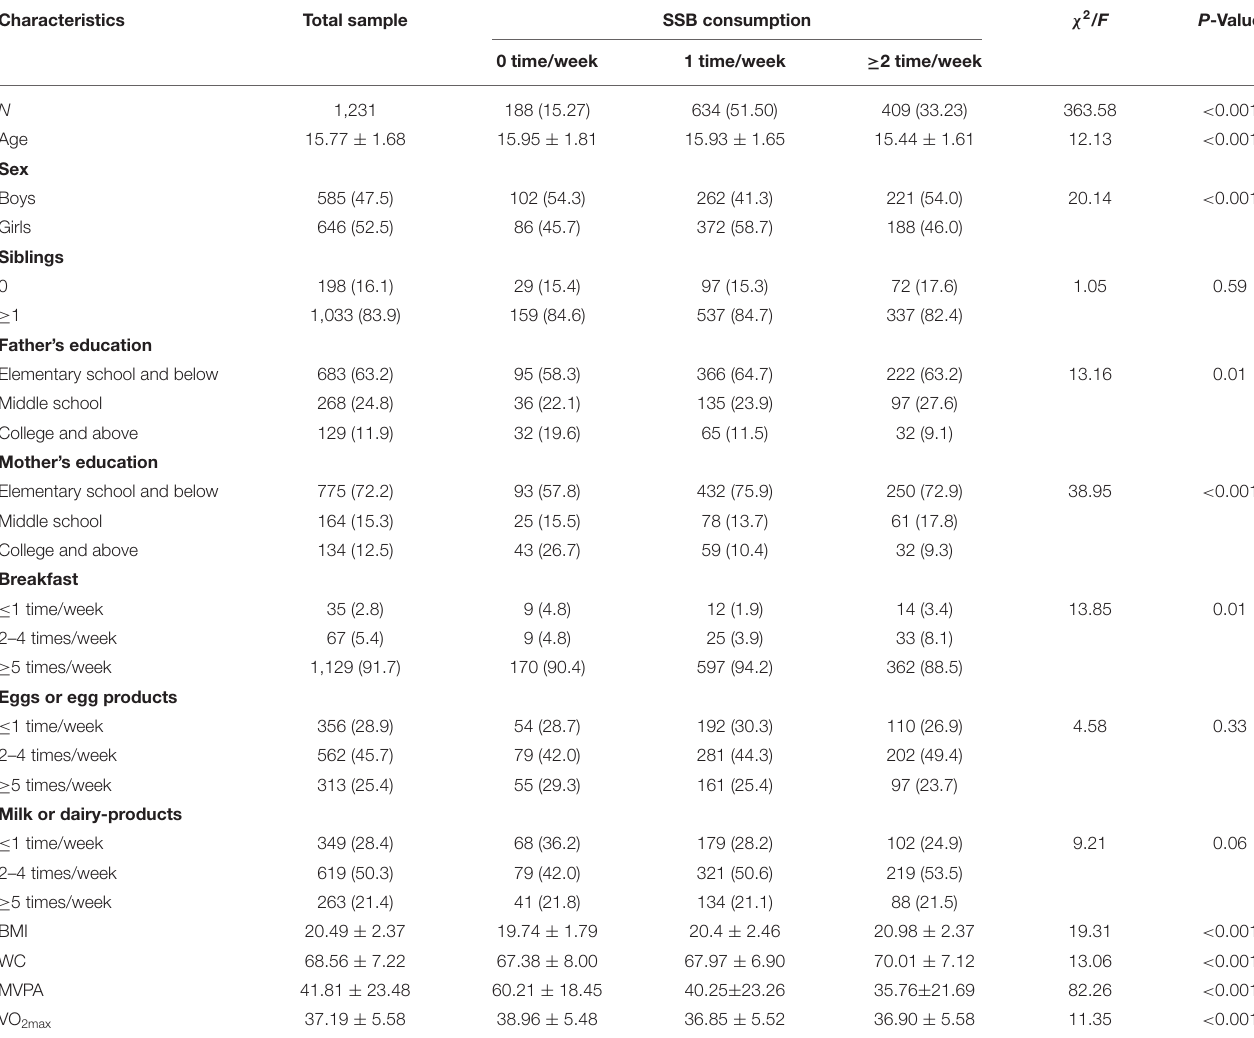
TABLE 1 | The SSB consumption status of Chinese Tibetan adolescents in Tibet, China. Characteristics